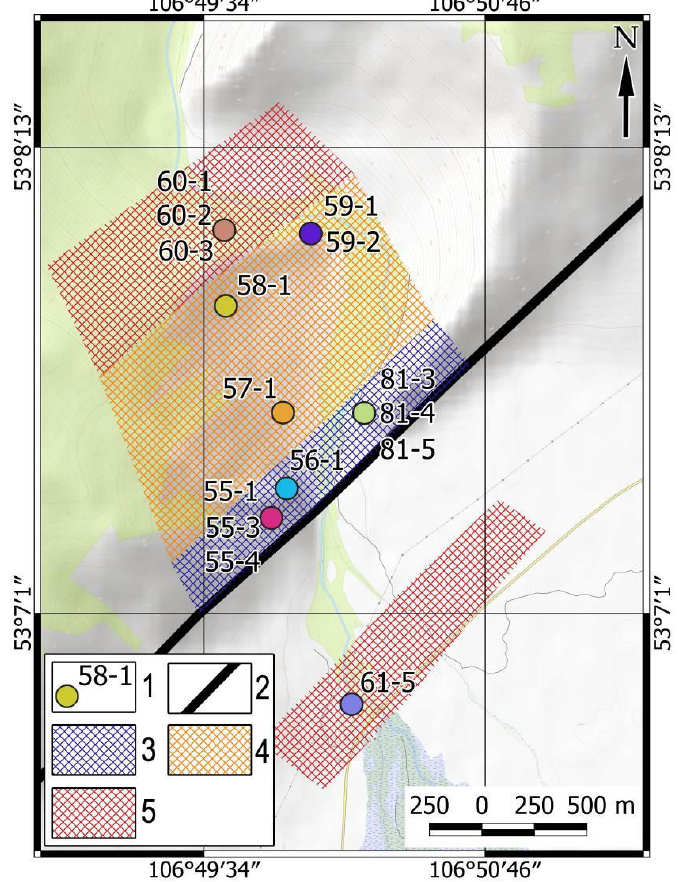
Figure 12. Scheme of heterogeneity of the Primorsky Fault zone based on microstructural analysis: 1 — Sampling points and their numbers; 2 — Primorsky Fault; 3 — Cluster with low porosity and permeability, zone of blastomylonites and brittle and ductile deformations; 4 — Cluster with medium porosity and permeability, zone of cataclasites and brittle deformations; 5 — Cluster with high porosity and permeability, zone of cataclasites and blastocataclasites and brittle deformations.